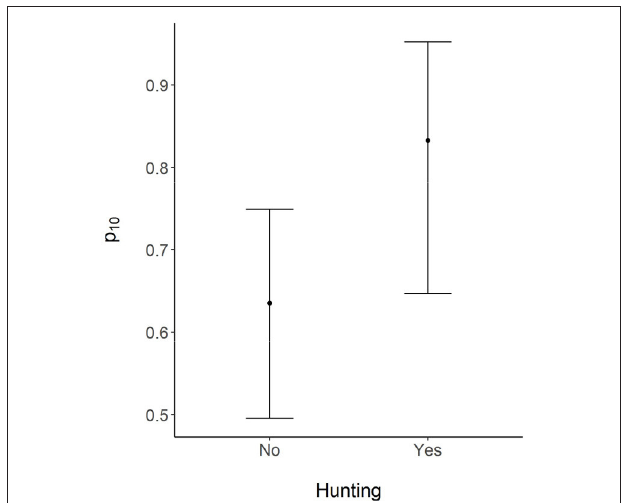
FIGURE 3 | Mean probability of falsely reporting conflicts with wild boar by respondents who did (Yes) and did not (No) favor removal of the prevailing ban on lethal removal of problem wildlife. Error bars represent 95% credible